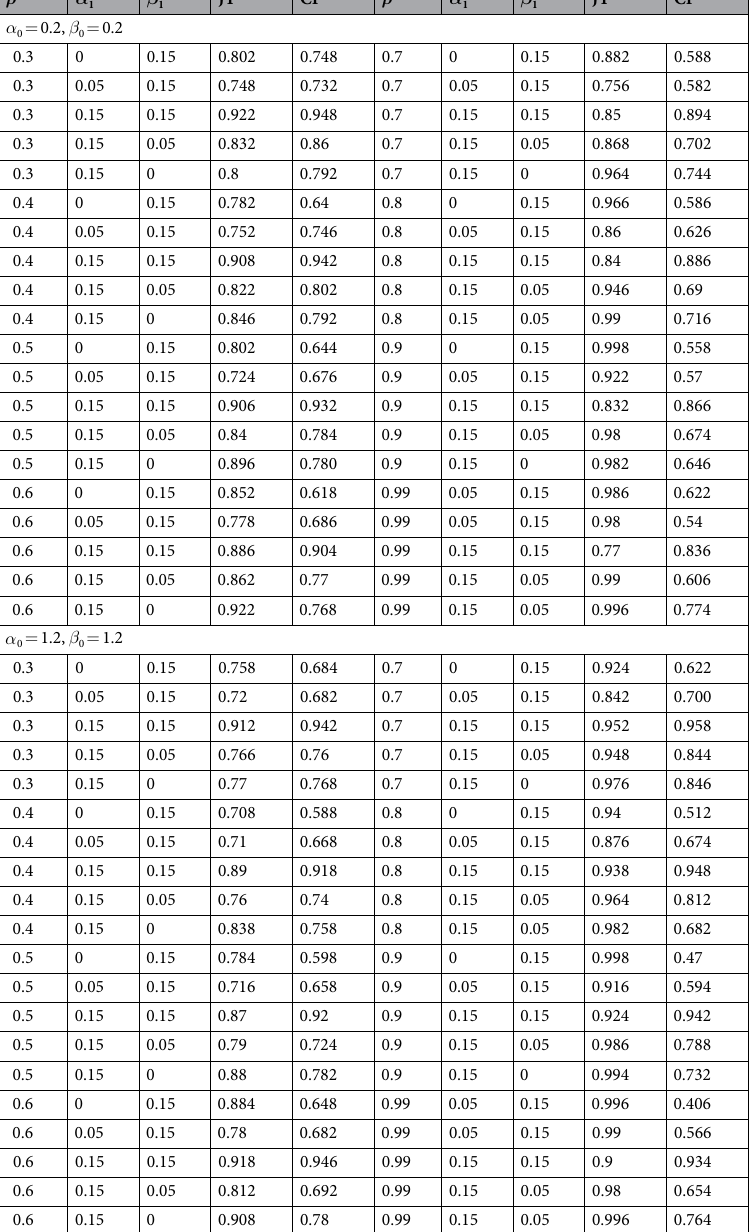
Table 3. Empirical powers for tests JT and CP with 3 ordinal categories( k =